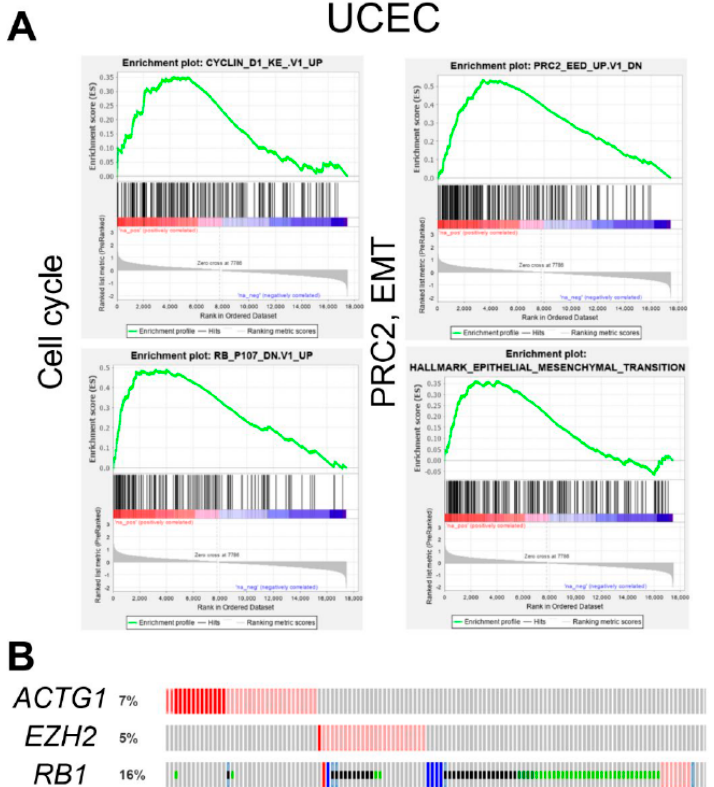
Figure 4. UCEC with ACTG1 gains exhibits increased cell cycle, EMT, and PRC2 activity. ( A ) Gene Set Enrichment Analysis (GSEA) of ACTG1 in the UCEC cohort (n = 509 samples) shows enrichment of cell cycle (cyclin and RB), epithelial to mesenchymal transition (EMT) and PRC2 activity. The peak of the graph indicates the enrichment score, the bars in the middle show where the genes related to the pathway are located in ranking (red / left = positive correlation, blue / right = negative correlation). ( B ) OncoPrint of genetic alterations in ACTG1, EZH2 , and RB1 . Each row is ordered by the patient ID and the colored vertical lines represent the observance of genomic alteration in one patient; red = amplification, pink = overexpression, blue = deletion, green = mutation. ACTG1 and EZH2 are not altered in the same patient samples.